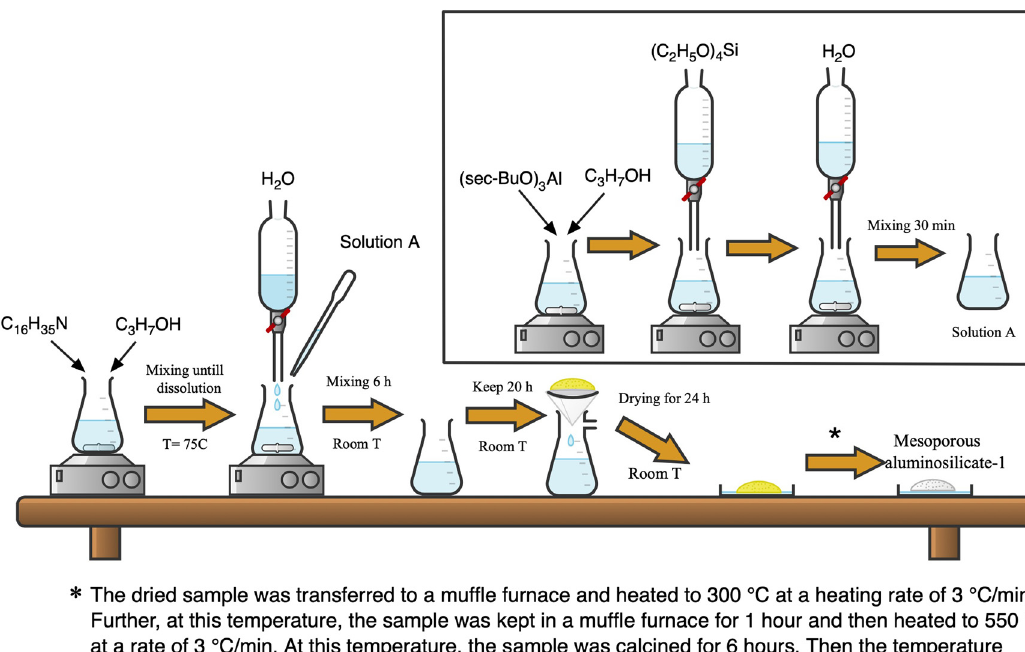
Figure 1: Scheme of synthesis of MAS by copolycondensation